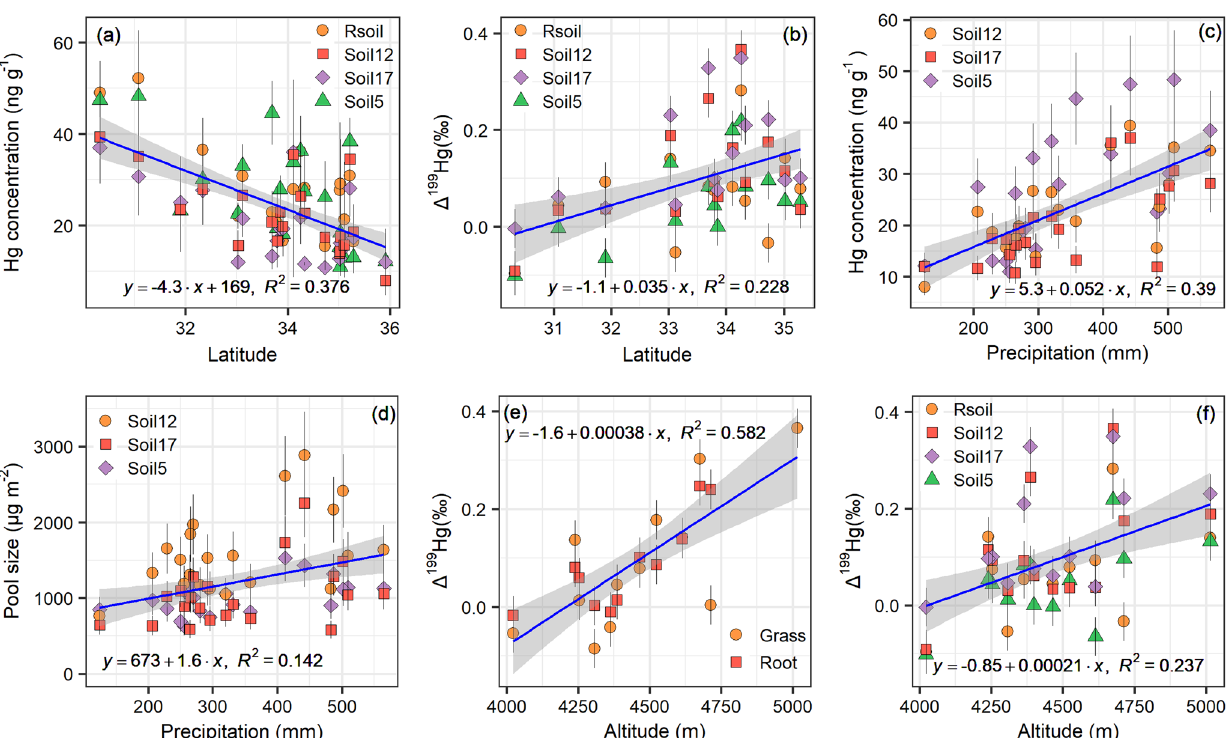
Fig. 2 Relationship between mercury (Hg) concentration and latitude, precipitation, and altitude. a Correlations for Hg concentration versus latitude, b Δ 199 Hg in soils versus latitude, c precipitation versus Hg concentration in soils, d precipitation versus pool size in soils, e Δ 199 Hg in vegetation versus altitude, f Δ 199 Hg in surface soils versus altitude. The shading of a − f represents the 95% con fi dence interval for regression and error bars stand for 1 σ